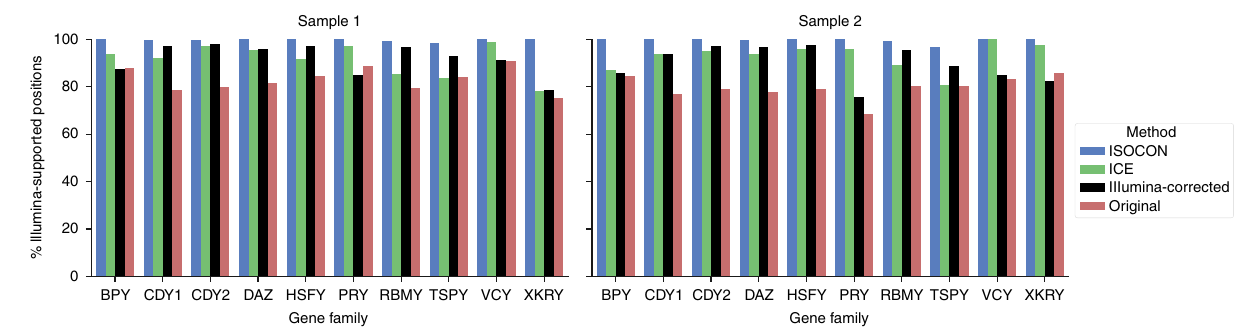
Fig. 3 Illumina-support of predicted transcripts. Barplot shows percentages of positions in IsoCon/ICE/proovread, and original CCS fl nc reads that are supported by at least two Illumina alignments with the same nucleotide